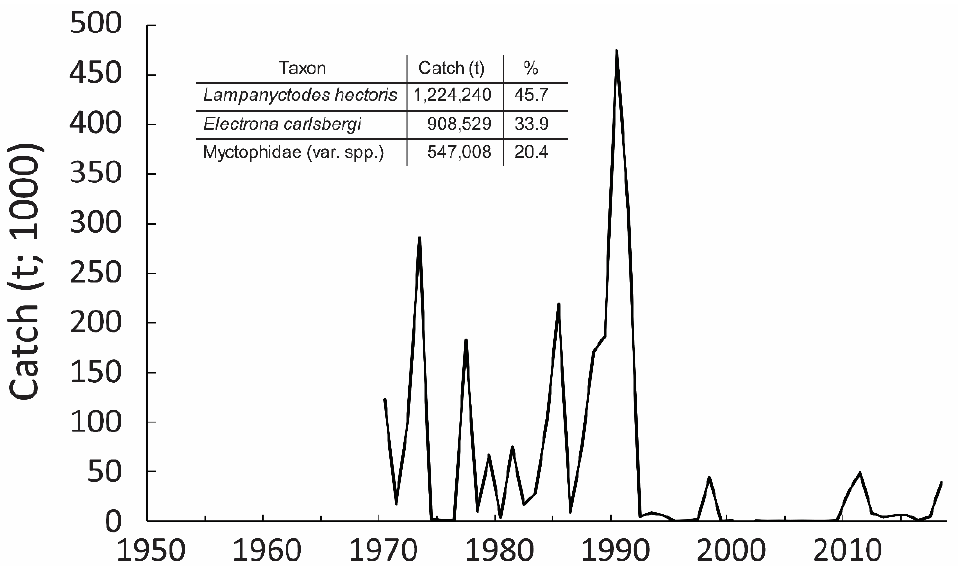
Figure 3. Landings officially reported to the FAO by its member countries totaling 2.68 million tonnes from 1950–2018, mainly the U.K. (South Georgia and Sandwich Islands, reporting 47%), South Africa (Atlantic and Cape, 37%), and Iceland (13%). Table 4. Catch information for 20 mesopelagic fishes depicted in Figure 3 by country/region and year.